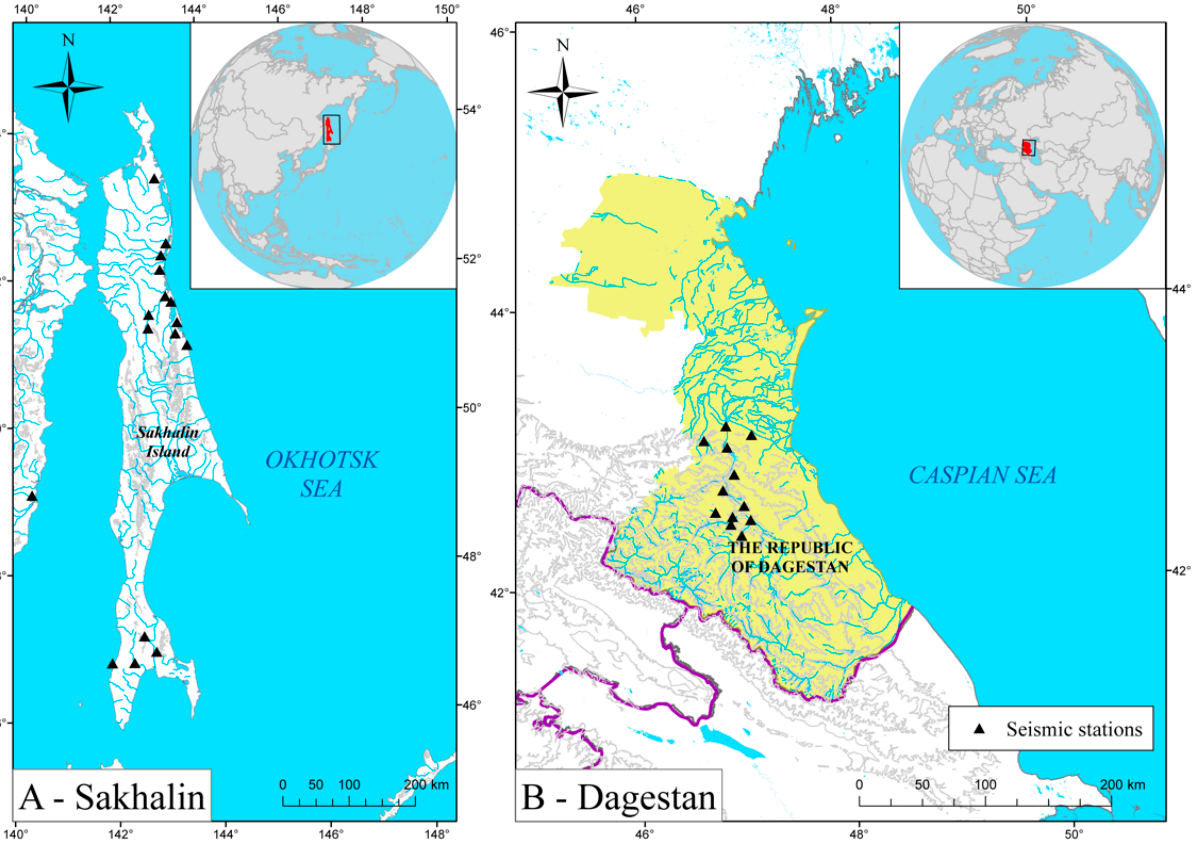
Figure 2. Location of local seismic networks and the geometry of the stations for Sakhalin (A) and Dagestan (B) regions that were used for the data acquisition.